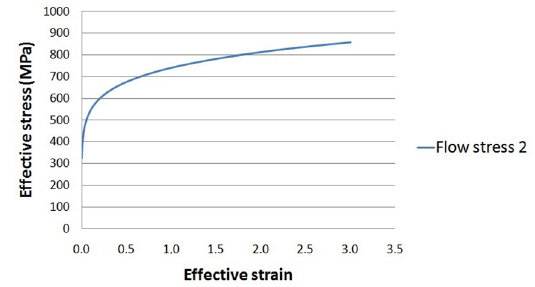
Figure 3. Flow stress curve used in simulations 3 and